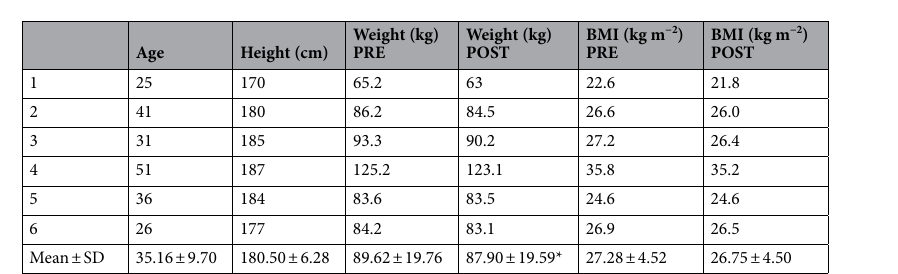
Table 1. Anthropometric parameters of the six sailors. Parameters collected from the sailors at Pre and Post. BMI Body Mass Index. *p < 0.05.